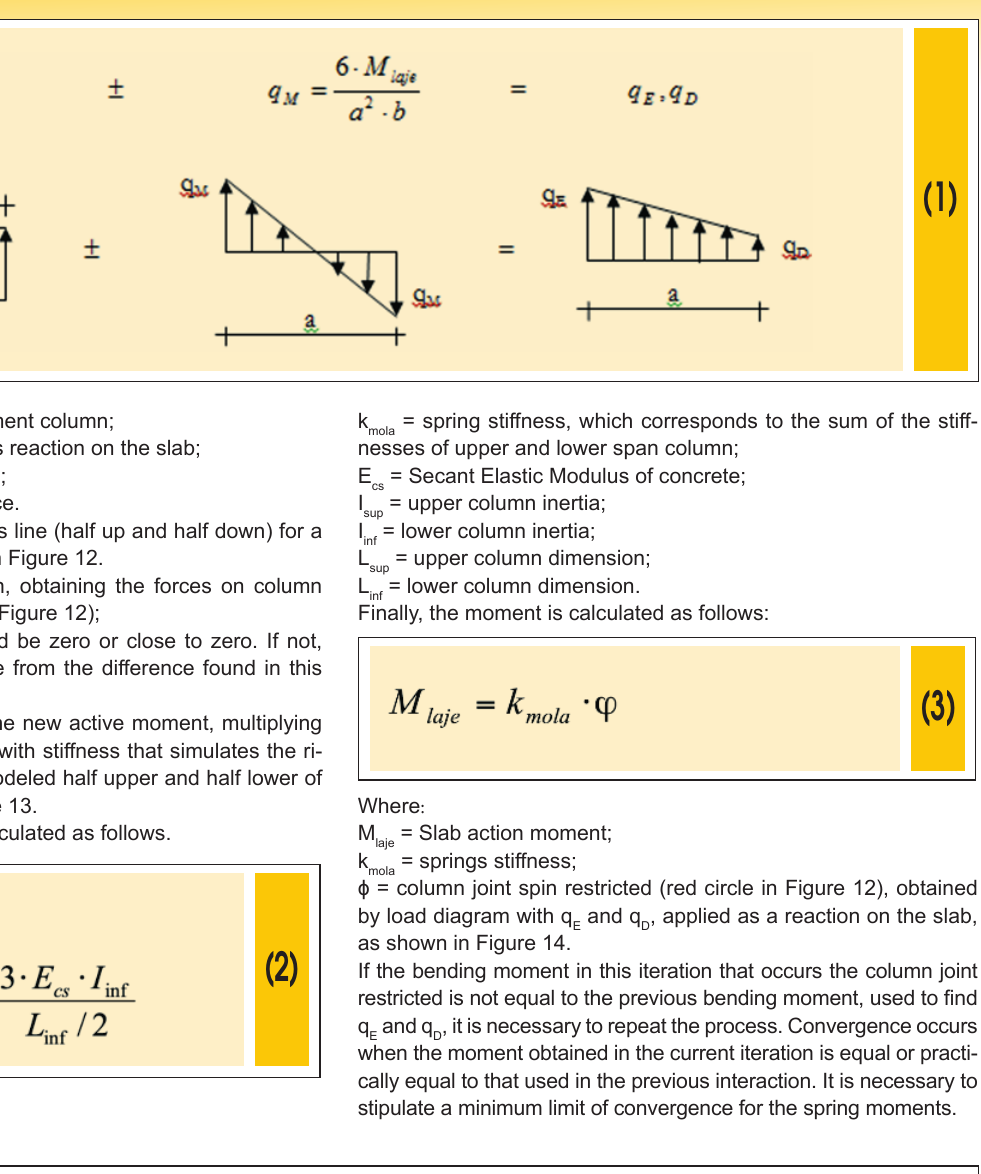
Figure 9 – Rigid sections according NBR 6118:2014